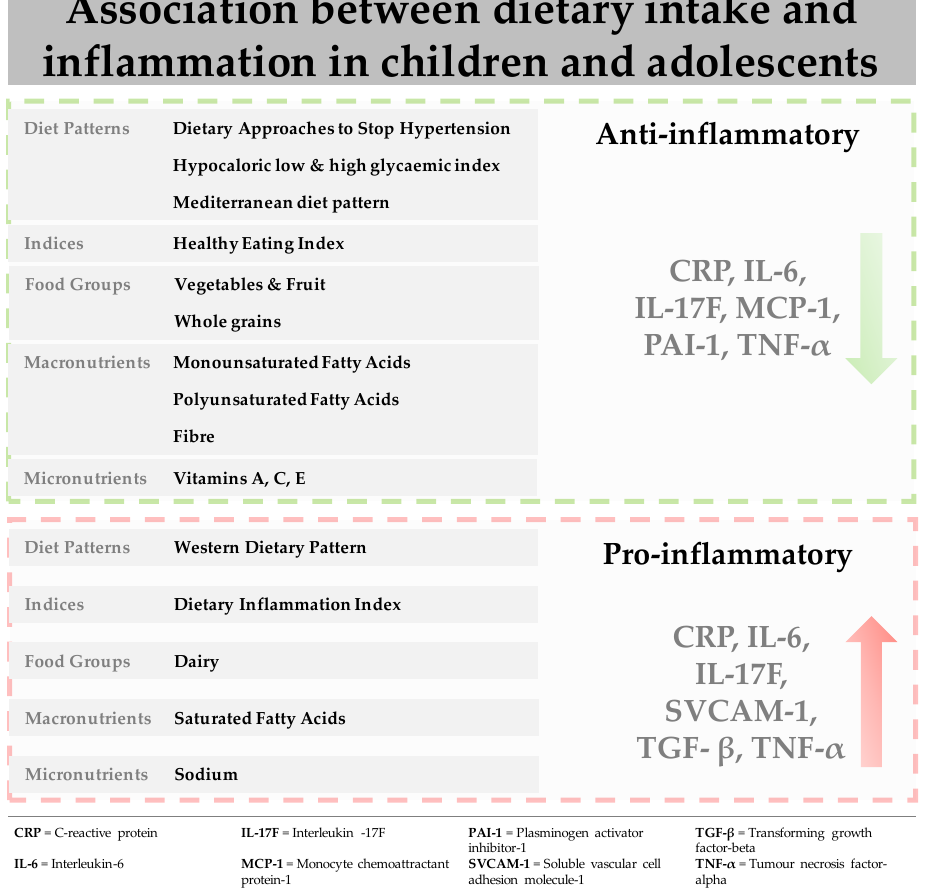
Figure 2. Association between dietary intake and biomarkers of inflammation in children and adolescents.